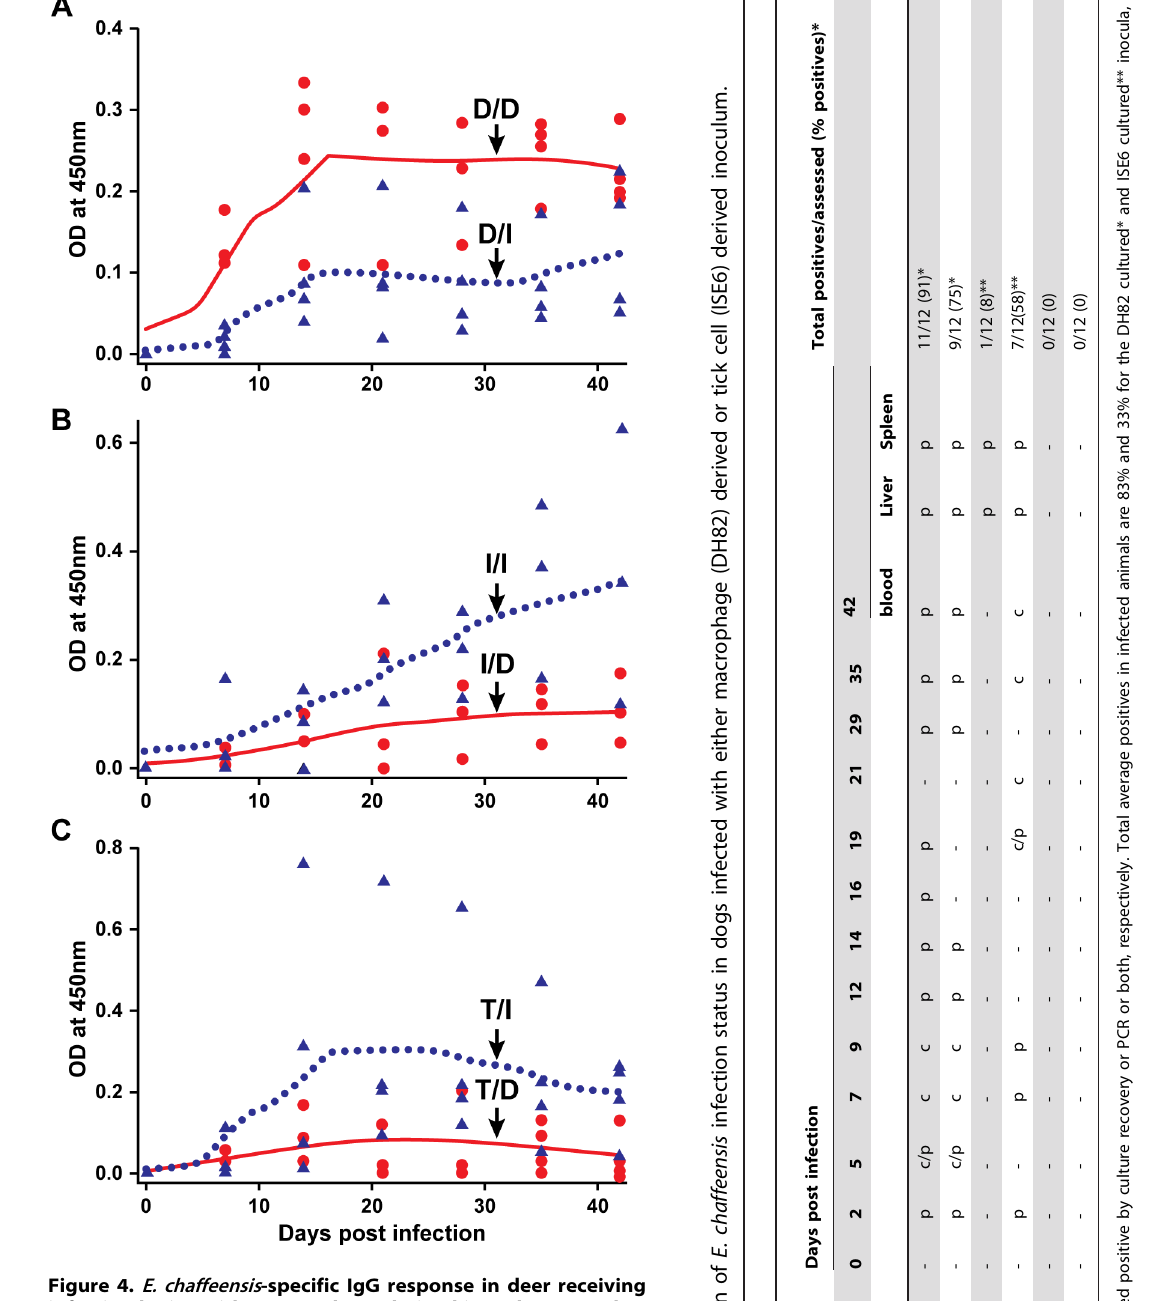
Figure 4. E.chaffeensis -specific IgG response in deer receiving infection by i.v. with DH82 culture-derived inoculum (panel A) or i.v. with ISE6 culture-derived organisms (panel B) or by tick transmission (panel C). Black circle data points and black line (polynomial smoothened line) in panel A refer to IgG data for DH82 culture infected animals using DH82 culture-derived antigens (D/D), while the black triangles and dotted line represent IgG response data generated with ISE6 culture-derived antigens (D/I). Panel B; as in A, except that the deer in this group were infected with ISE6 culture- derived inoculum and antigens used in the ELISA analysis are either from DH82 (I/D) (black circle data points and black line) or ISE6 (I/I) (black triangles and dotted line). Panel C represent IgG data for tick- transmitted animals and antigens used in the ELISA analysis are either from DH82 (T/D) (black circle data points and black line) or ISE6 (T/I) (black triangles and dotted line) culture derived. The Y-axis scales differ between charts.